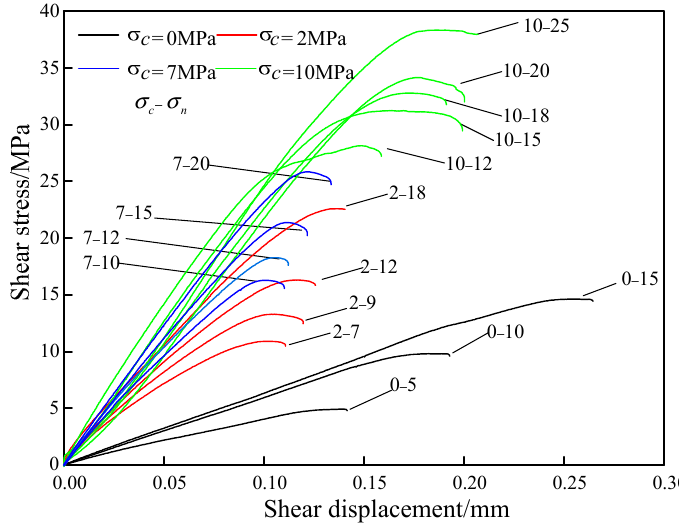
Figure 9. Shear stress versus shear displacement curves of rock fractures under different lateral stresses.